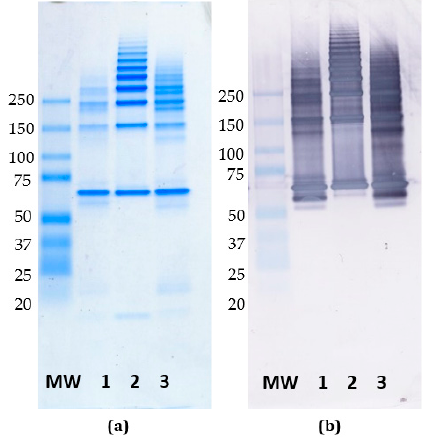
Figure 6. Native PAGE and Western blotting of wild-type calreticulin. ( a ) Coomassie staining of oligomerized calreticulin. ( b ) Western blotting of mAb FMC 75 to oligomerized calreticulin.